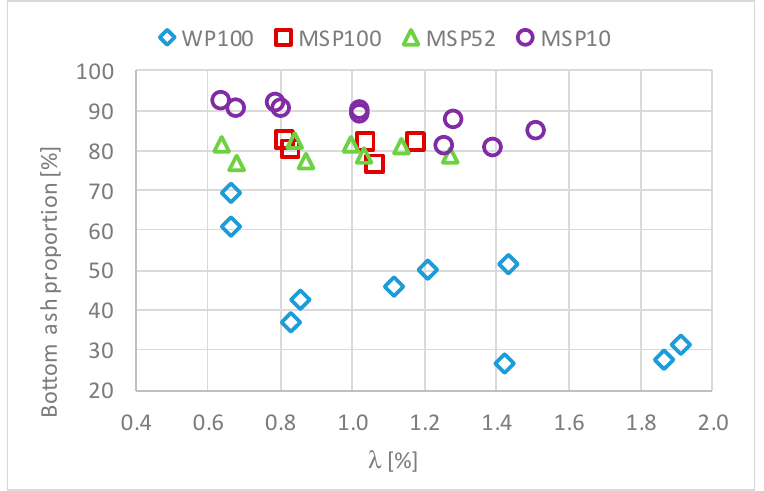
Figure 9. Bottom ash proportion (% with respect to the total amount of ash introduced with the fuel) versus λ for the WP100 and MSP family.